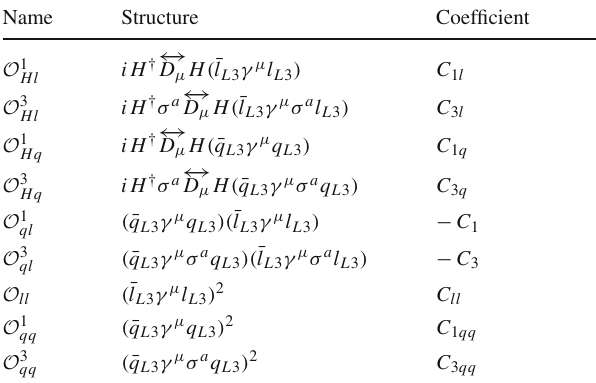
Table 1 The 9 operators relevant for the electro-weak fit. They define an effective lagrangian V 2 L = Name